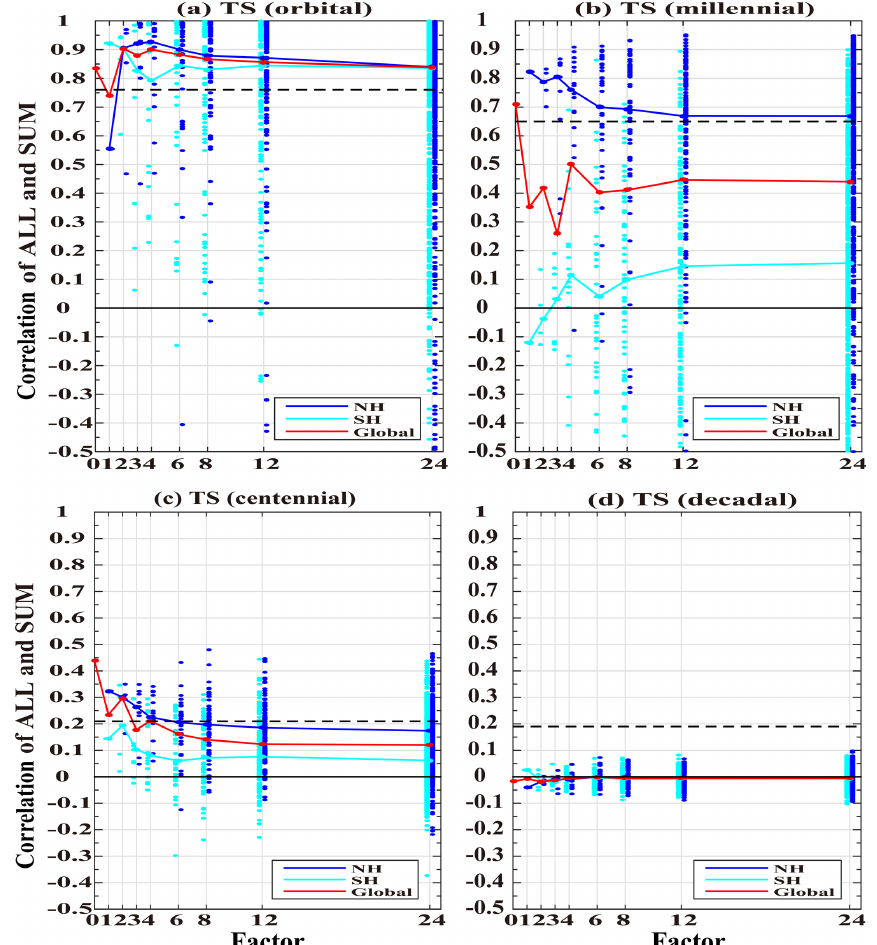
Figure 3. Correlation coefficient of mean surface temperature between the ALL and SUM outputs in different spatial timescales. (a) Orbital; (b) millennial; (c) centennial; (d) decadal. The blue dots for NH, cyan dots for SH and red dots for all the correlation coefficient median on the same global spatial scale (i.e., factor). The red line connects the median dots at all division factors. The blue (cyan) line connects the median of all blue (cyan) dots at all division factors. The black thick dashed line is the 95% confidence level. The black thin solid line is 0. The x axis is division factor, and the y axis is the correlation coefficient. There are only about 10 points with the correlation coefficient lower than − 0 . 5 so they are ignored in (a–c)